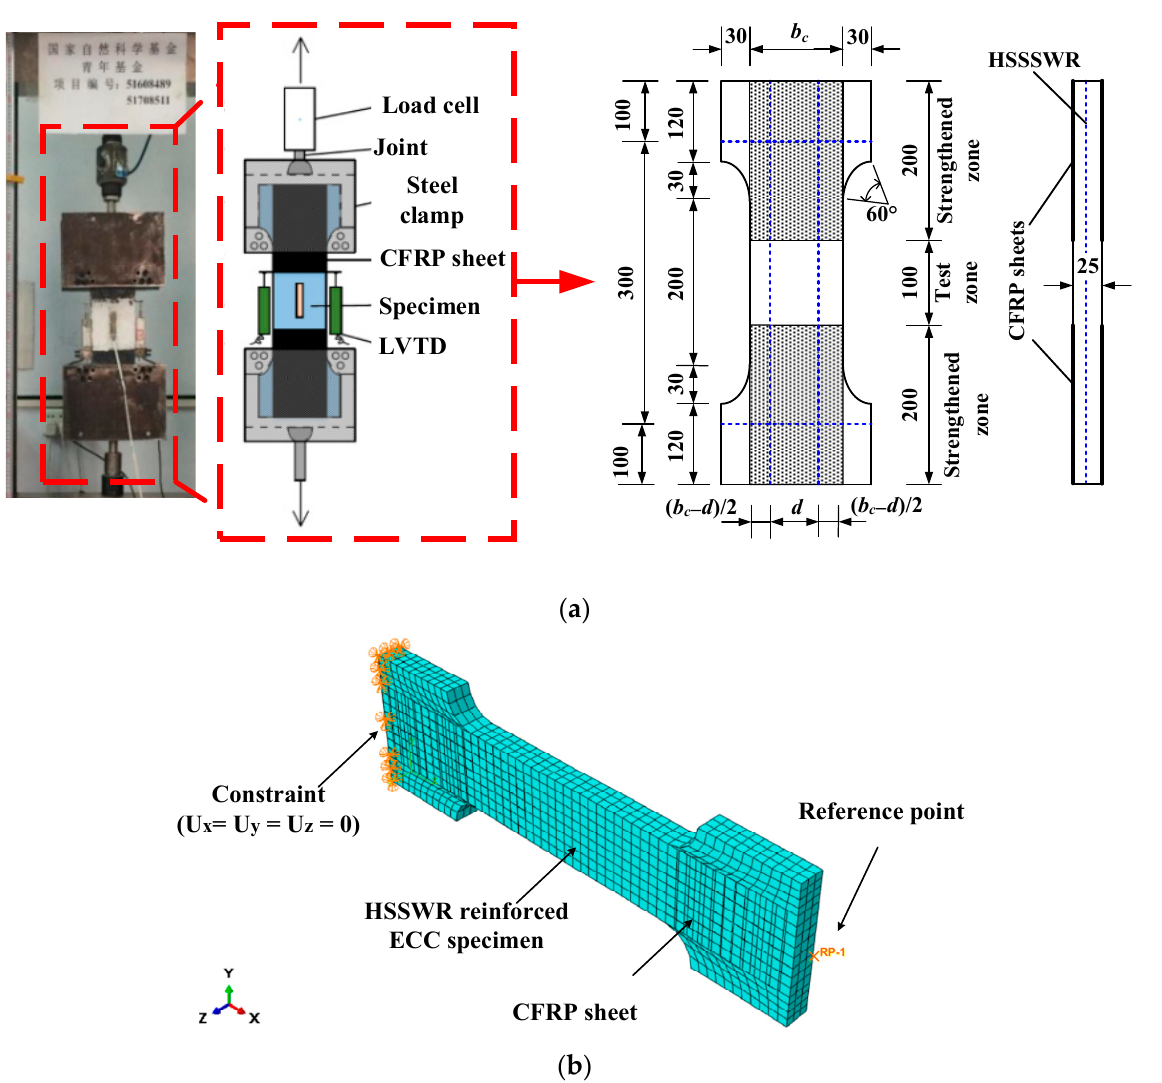
Figure 7. Test setup and 3D FE model of specimens: ( a ) test setup and specimen details (The Chinese project fund in the picture is not related to the research in this paper); ( b ) 3D FE model.